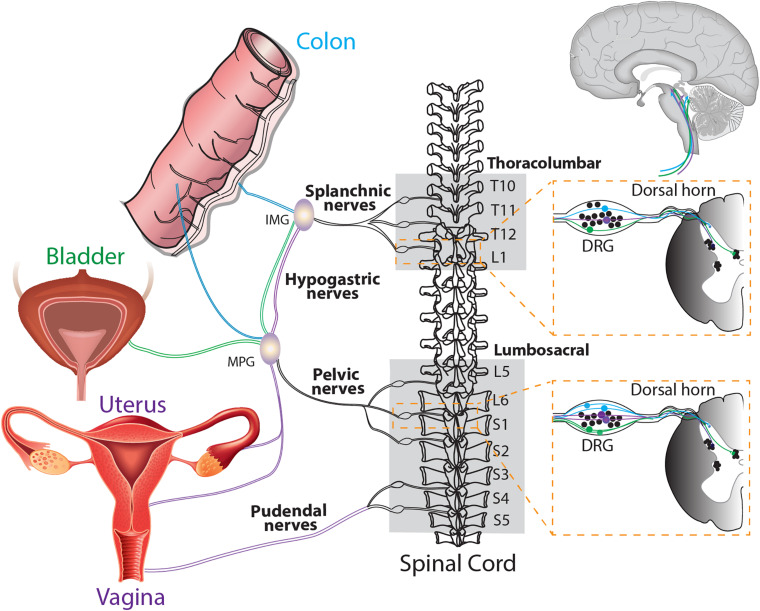
Schematic overview of the sensory innervation of the colon, bladder and uterus/vagina allowing for cross organ sensitization. The colon is innervated by spinal afferents within the splanchnic and pelvic pathways. These spinal afferents can travel via the splanchnic or pelvic nerves (with some afferents traversing the hypogastric nerve) and have cell bodies located within the thoracolumbar and lumbosacral dorsal root ganglia (DRG). The bladder is also innervated by both splanchnic and pelvic pathways (de Groat et al., 2015). The central terminals of colon and bladder afferents terminate within the dorsal horn of the thoracolumbar and lumbosacral dorsal horn (Harrington et al., 2012, 2019; Grundy et al., 2018). Afferents innervating the uterus and vagina also share the splanchnic and pelvic pathways, whilst the vagina is also innervated by the pudendal nerves, with cell bodies within the lumbosacral DRG and central terminals within the lumbosacral dorsal horn (Berkley, 2005). The central terminals of colon, bladder, uterus and vaginal afferents synapse onto second order dorsal horn neurons in the spinal cord, which ultimately transmit signals to the brain. Accordingly, these different visceral organs share common nerve pathways to the DRG and spinal cord, allowing the potential for cross-organ sensitization. TL, Thoracolumbar; LS, Lumbosacral; IMG, Inferior Mesenteric Ganglion; MPG, Major Pelvic Ganglion.